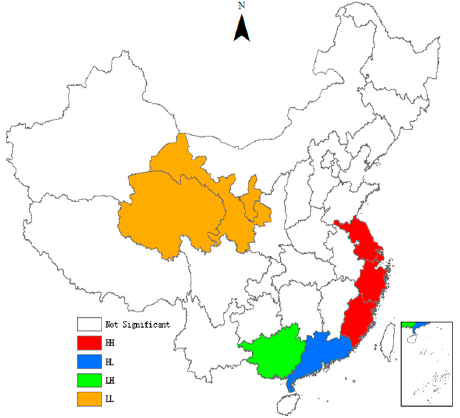
Figure 4. LISA agglomeration between 2014 and 2015.